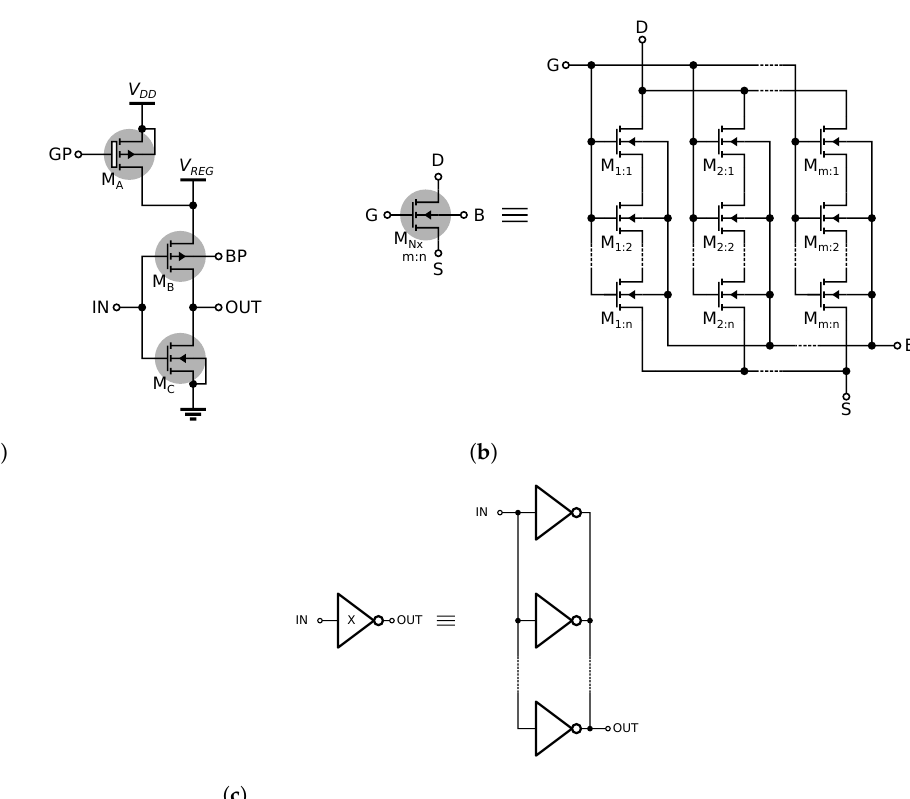
Figure 1. ( a ) Single inverter schematic, ( b ) transistor rectangular array, and ( c ) parallel inverters.